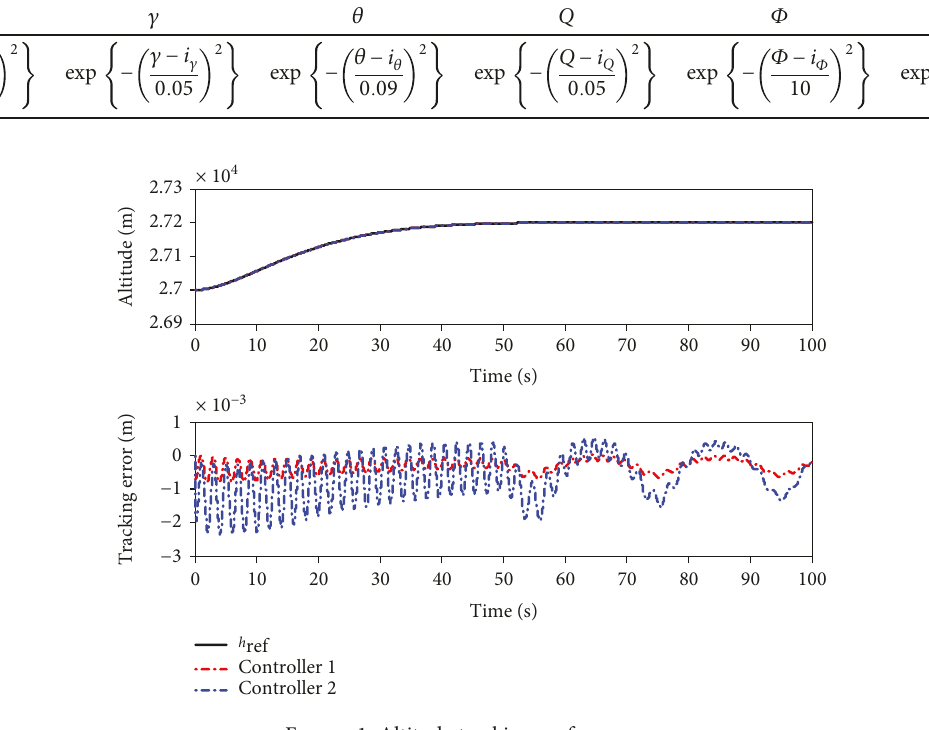
Figure 1: Altitude tracking performance.